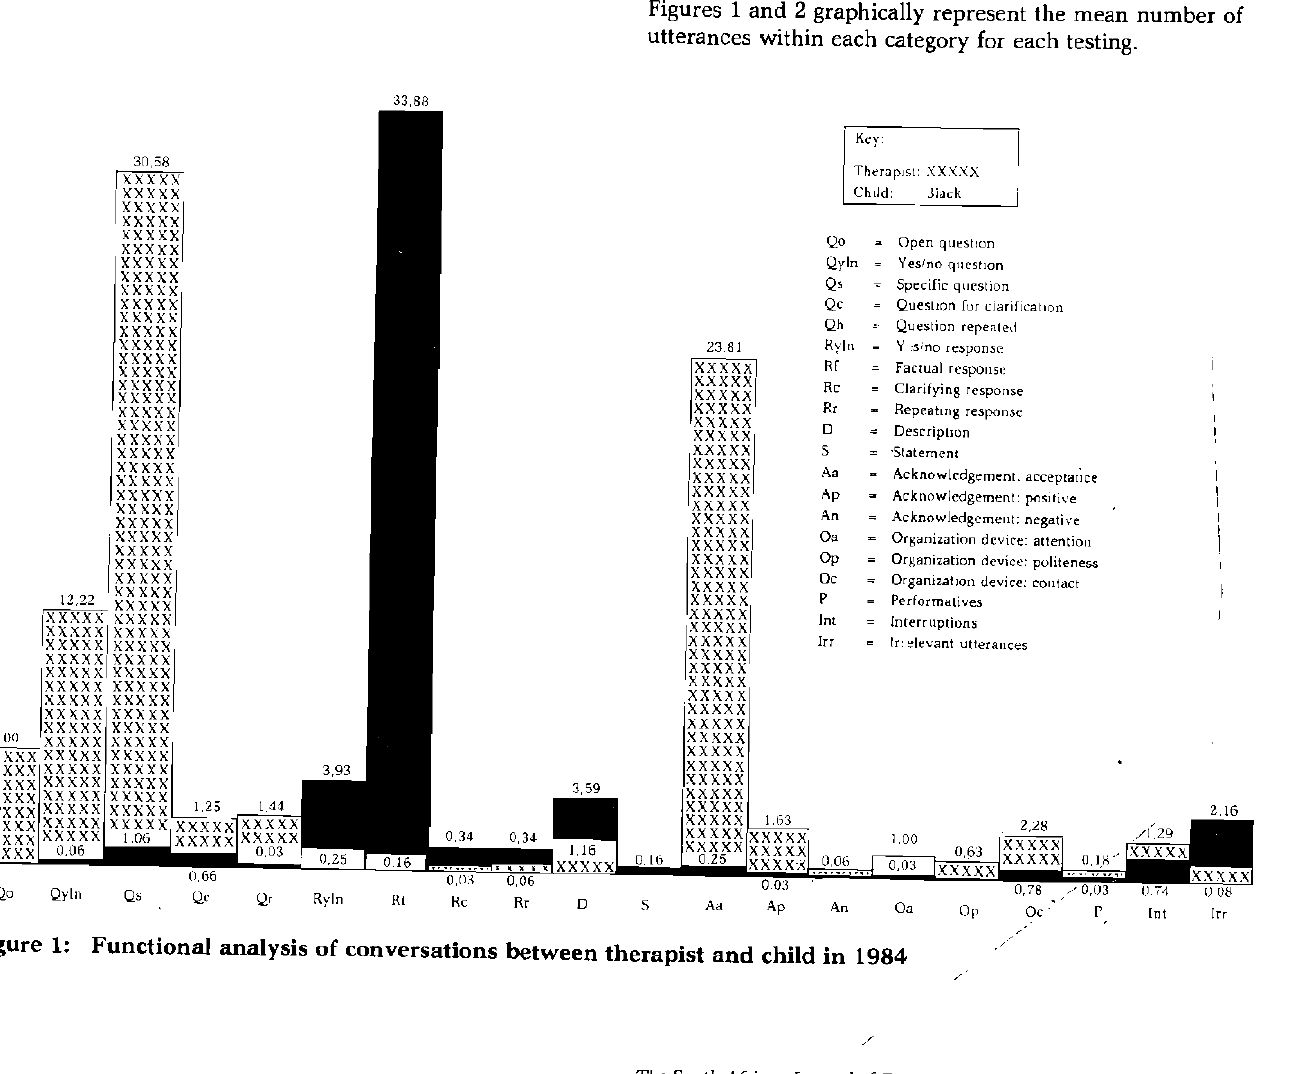
The South African Journal of Communication Disorders, Vol. 34,